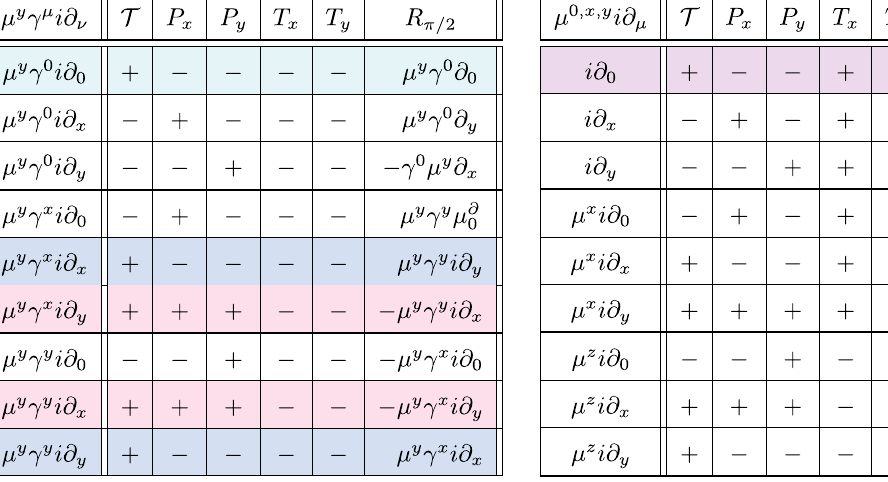
FIG. 5. Symmetry transformation properties of bilinears of the form tr ð σ a transform under spin. The operators that can couple to a Higgs field in a gapped symmetric spin Z 2 spin liquid are colored; entries with the same color transform into one another under R π